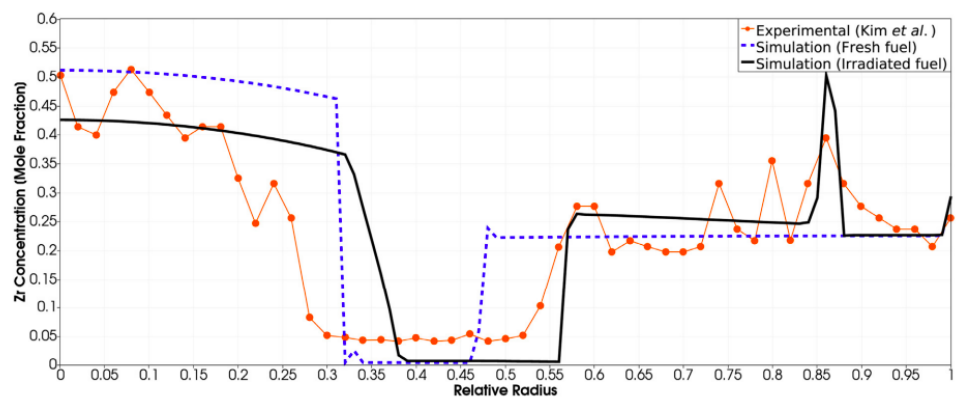
Figure 4. The predicted distribution of Zr is plotted when assuming fresh U-Pu-Zr fuel and irradiated fuel according to Poschmann et al. [43] with comparisons made to post-irradiation examination experiments from Kim et al.